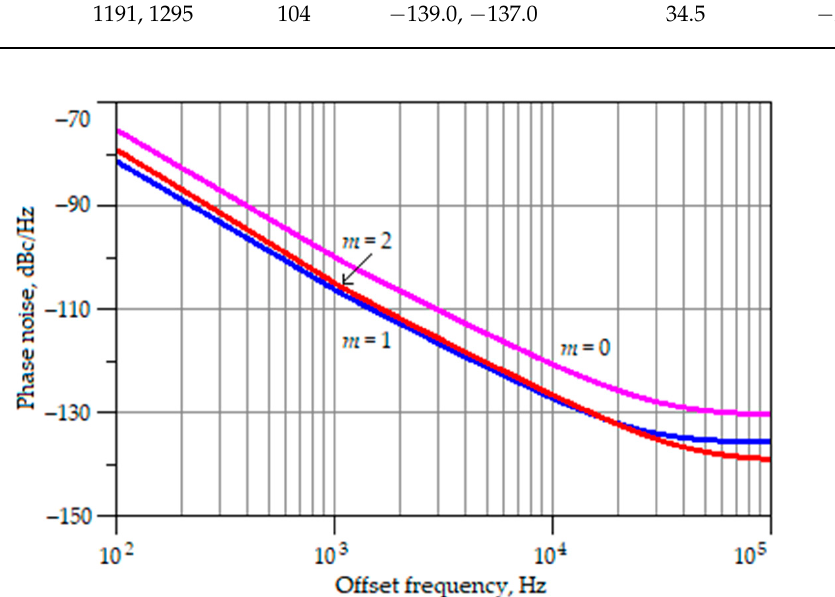
2 (see Figure 27).